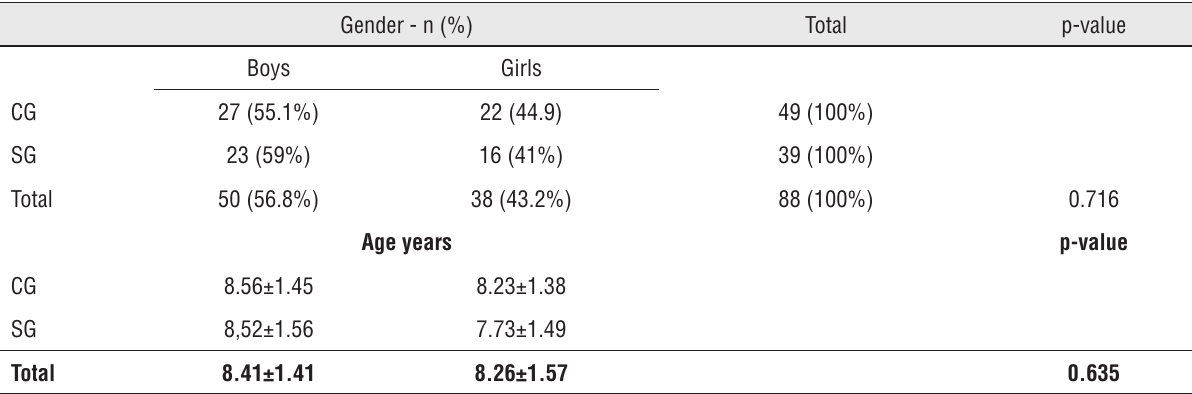
Table 1 - Distribution of the children included in the study according to gender and age Gender - n